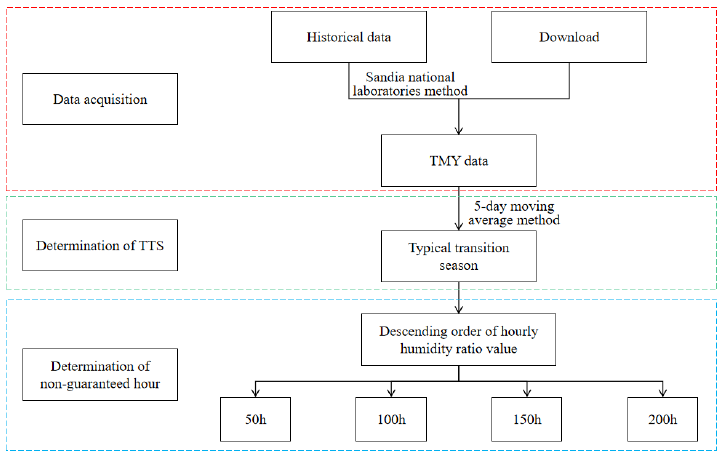
Figure 3. Technical route of TTS